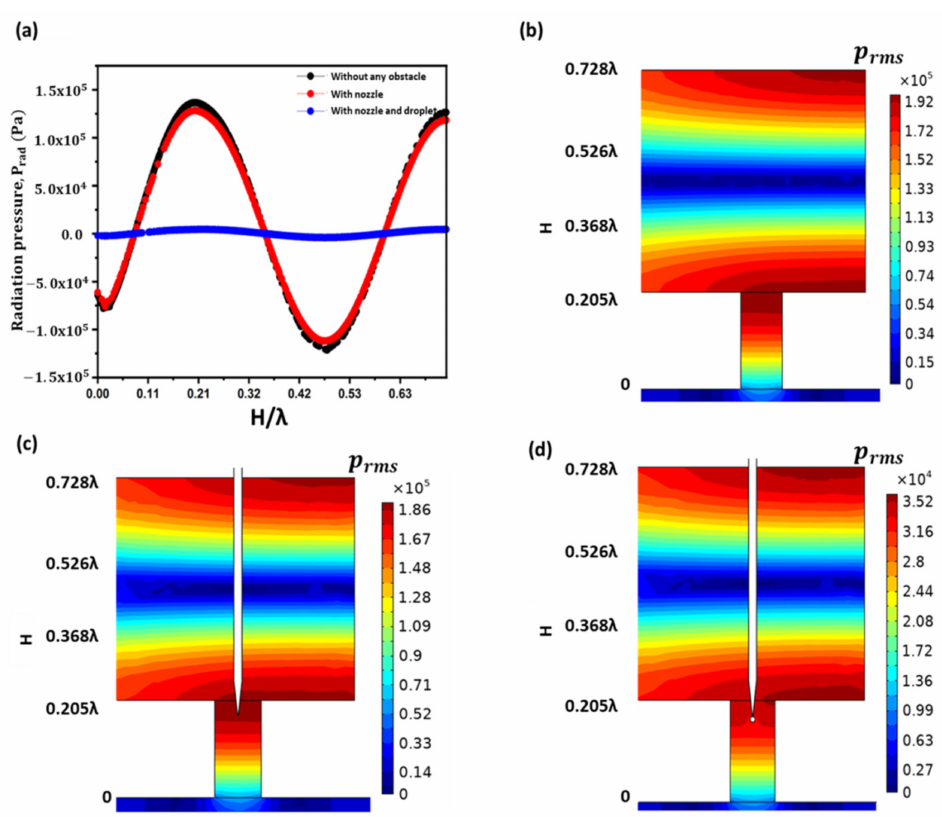
Figure 5. Numerical simulations of ( a ) standing wave of radiation pressure at acoustic cavity of height, H without any obstacle, with only nozzle, and with the nozzle and droplet, and RMS pressure distribution at acoustic cavity of height, H ( b ) without any obstacle, ( c ) with nozzle only, and ( d ) with the nozzle and